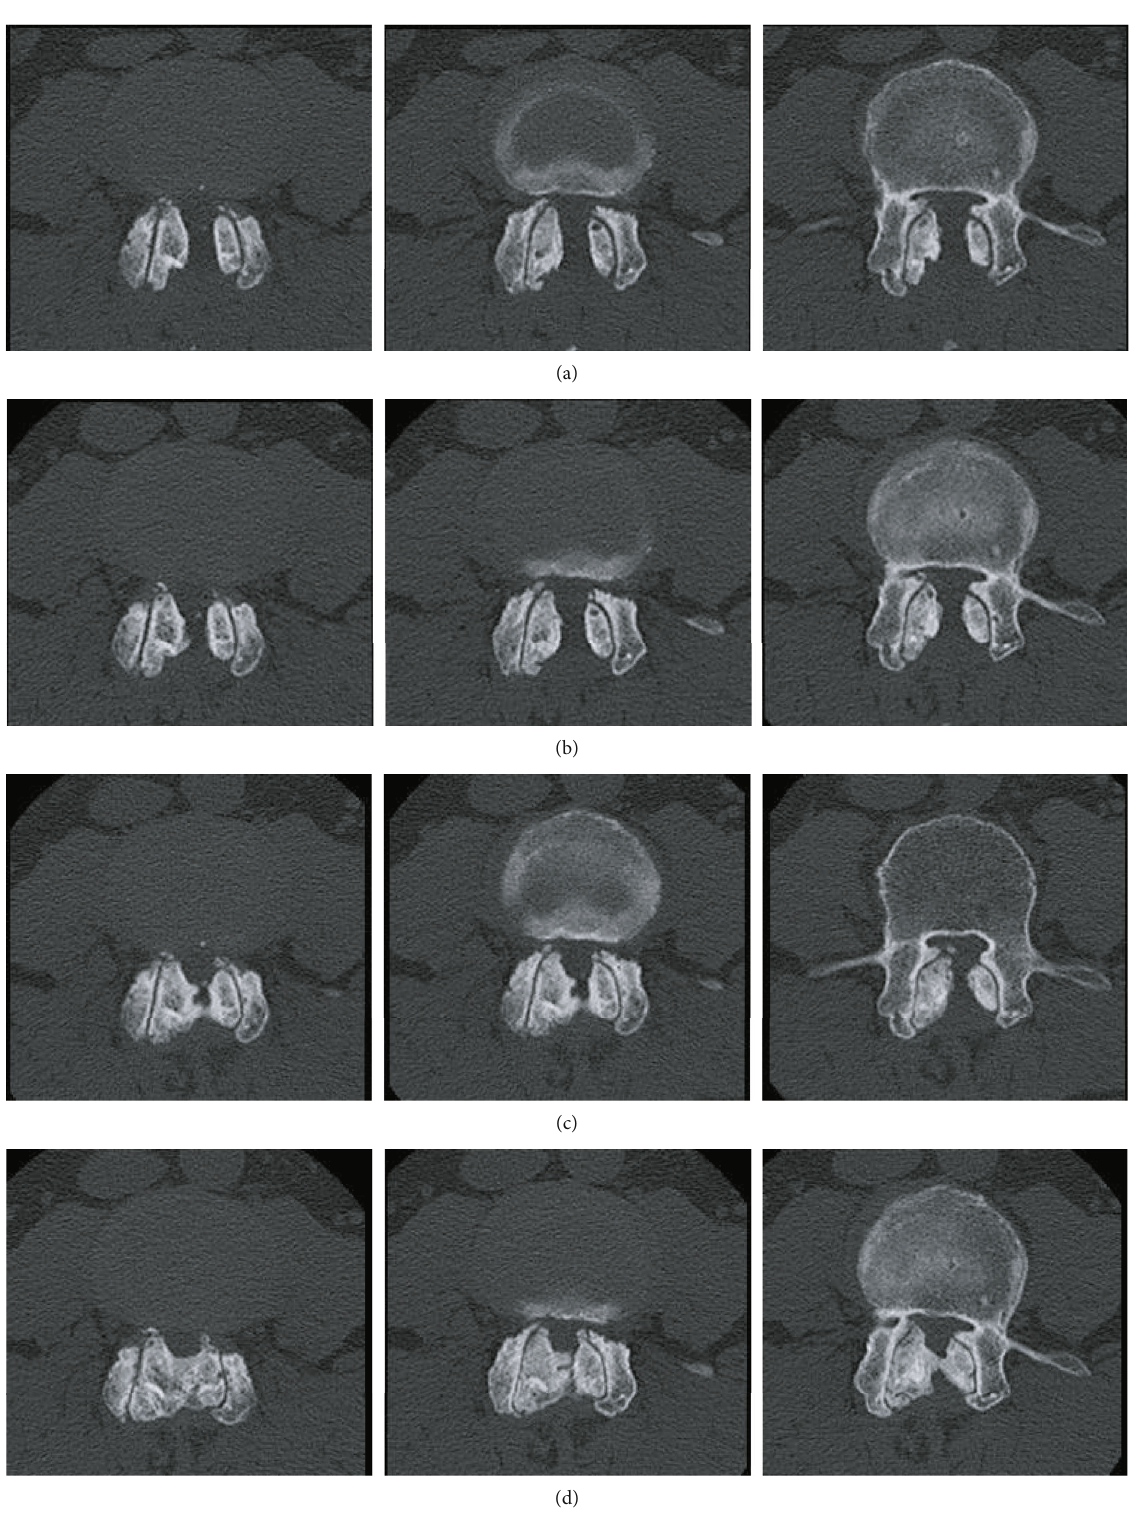
Figure 3: Computed tomography (CT) images after the second decompression surgery. (a) CT images 6 months after the second surgery. (b) CT images 1 year after the second surgery. (c) CT images 2 years after the second surgery showing bone regrowth mainly around the facet joints. (d) CT images 4.3 years after the second surgery showing the marked bone regrowth over the